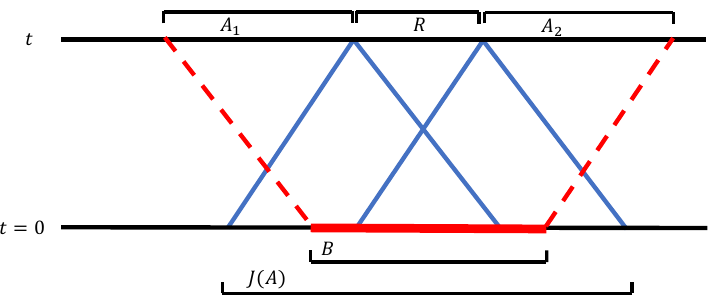
Figure 10 . For any B in J ( R ) such that R is in the light-cone of B , we can construct A 1 , A 2 such that K ( R ) ≡ D ( A 1 RA 2 ) ∩ J ( R ) = B . Then if G ( R, B, t ) does not agree with (3.9), then using (2.24), we see that the resulting S ( A 1 A 2 ) ( t ) will deviate from (3.11)–(3.12), and thus from the 2 holographic expression.